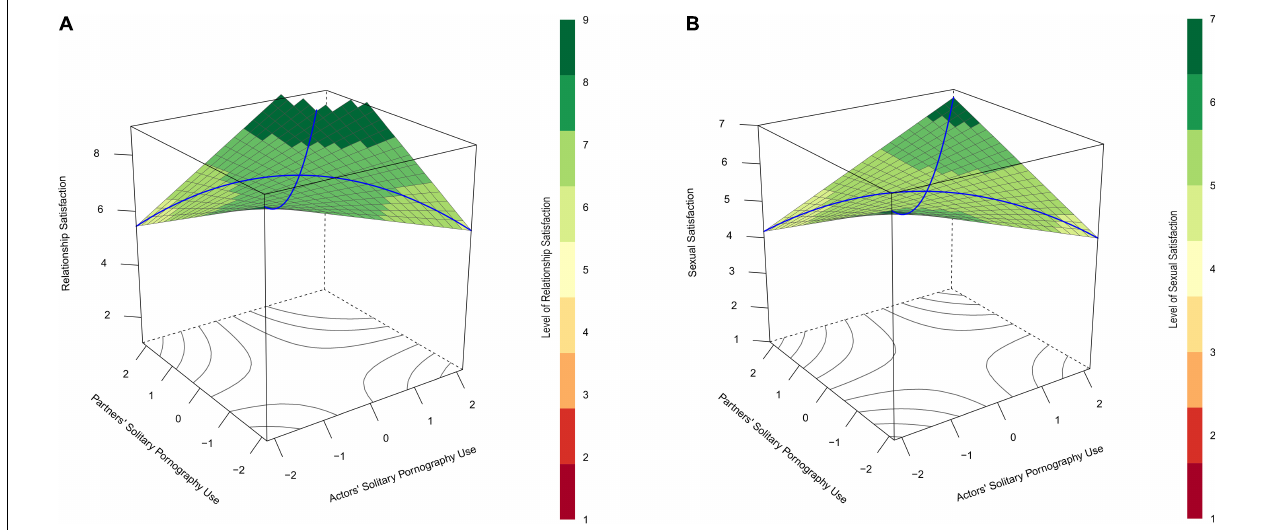
FIGURE 4 | (A) Depicts predicted relationship satisfaction (vertical axis) as a function of actors’ ( x -axis) and partners’ ( y -axis) frequencies of solitary pornography use and their interaction for cases that reported mean levels of shared pornography use in Study 3. (B) Does the same for the prediction of sexual satisfaction. In both figures, satisfaction scores tended to be lowest in cases in which couple members were most dissimilar in their frequencies of solitary pornography use (left- and right-most corners of the plots). According to regions of significance tests, participants’ own solitary pornography use was negatively related to their relationship satisfaction if their partners’ almost never used pornography alone or never used pornography (partners’ solitary pornography use < –1.15) but was positively related to their relationship satisfaction when their partners’ used pornography alone more than once or twice a week (partners’ solitary pornography use > 0.38). Similarly, further regions of significance tests found that sexual satisfaction was negatively related to participants’ solitary pornography when their partners used pornography alone less than one to three times a month (partners’ solitary pornography use < 0.85) but was positively related when their partners used pornography alone more once a day (partners’ solitary pornography use >